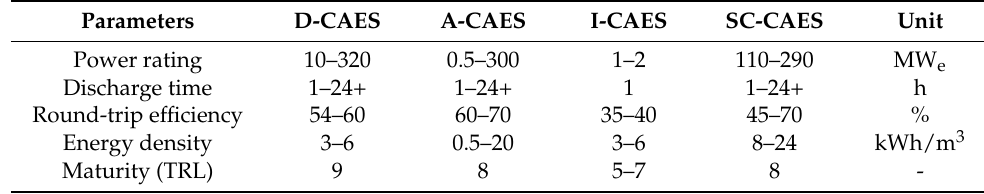
Table 2. Key technical parameters of different CAES configurations